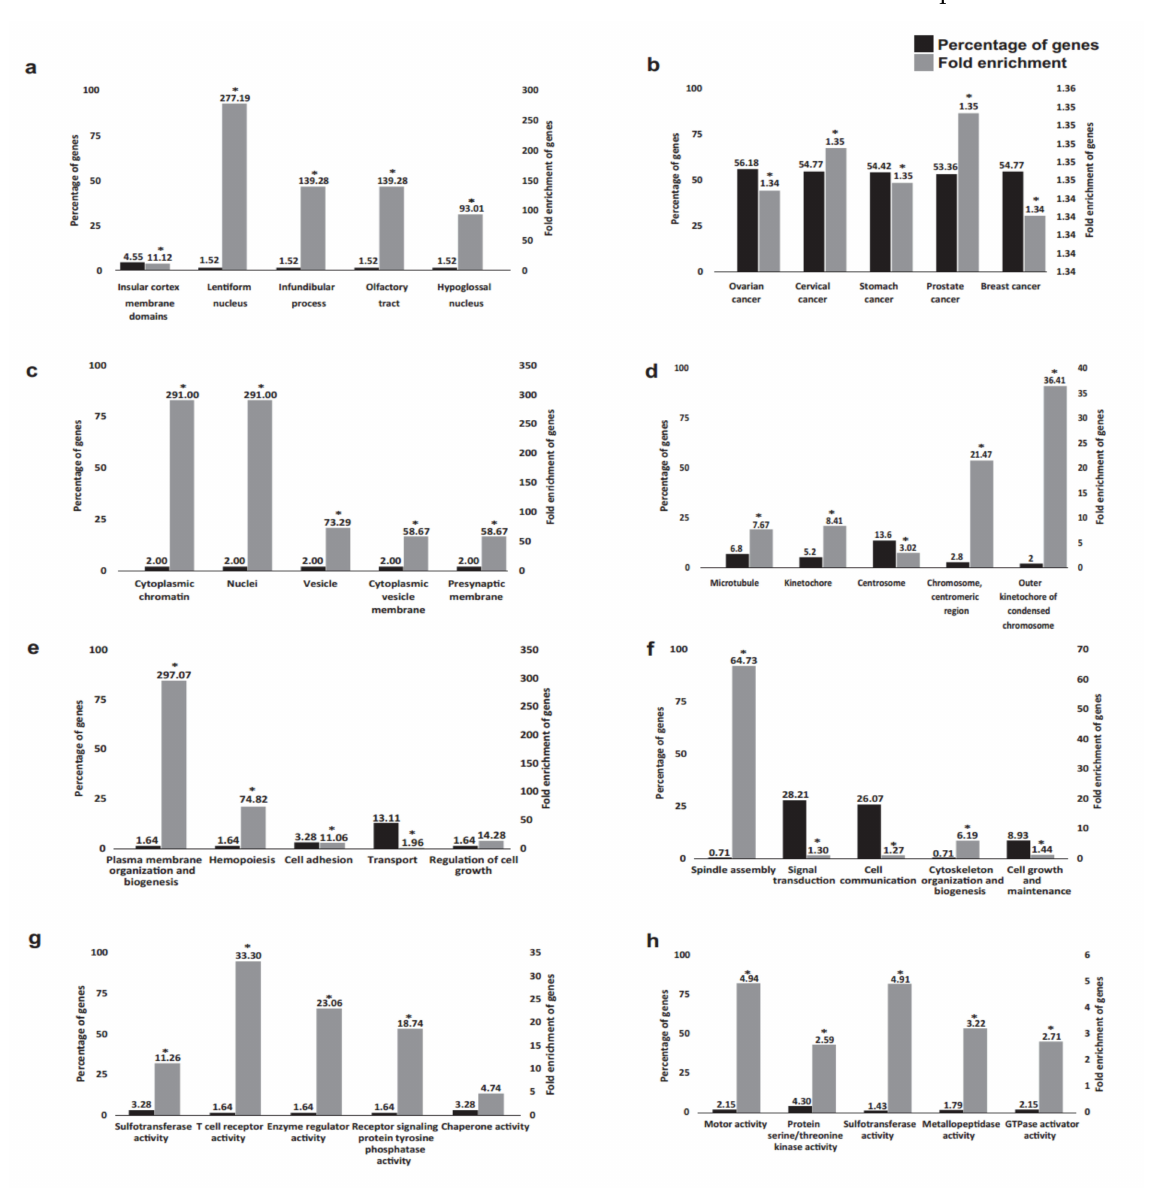
Figure 5. The functional enrichment in Gene Ontology terms in BPA 10 nM exposure DEGs ( a , c , e , g ) and BPA 100 nM exposure DEGs ( b , d , f , h ) in relation to site of expression ( a , b ), cellular components ( c , d ), biological processes ( e , f ), and molecular functions ( g , h ). * p < 0.05. Gene Ontology (GO) analysis indicated that the majority of genes affected by exposure to 100 nM BPA are also dysregulated in various female cancers (specifically, 159 genes in ovarian cancer and 155 genes in cervical and breast cancer). Notably, the current literature describes the impact of BPA exposure for only 2 genes out of the 76 identified by our study (Supplementary Figure